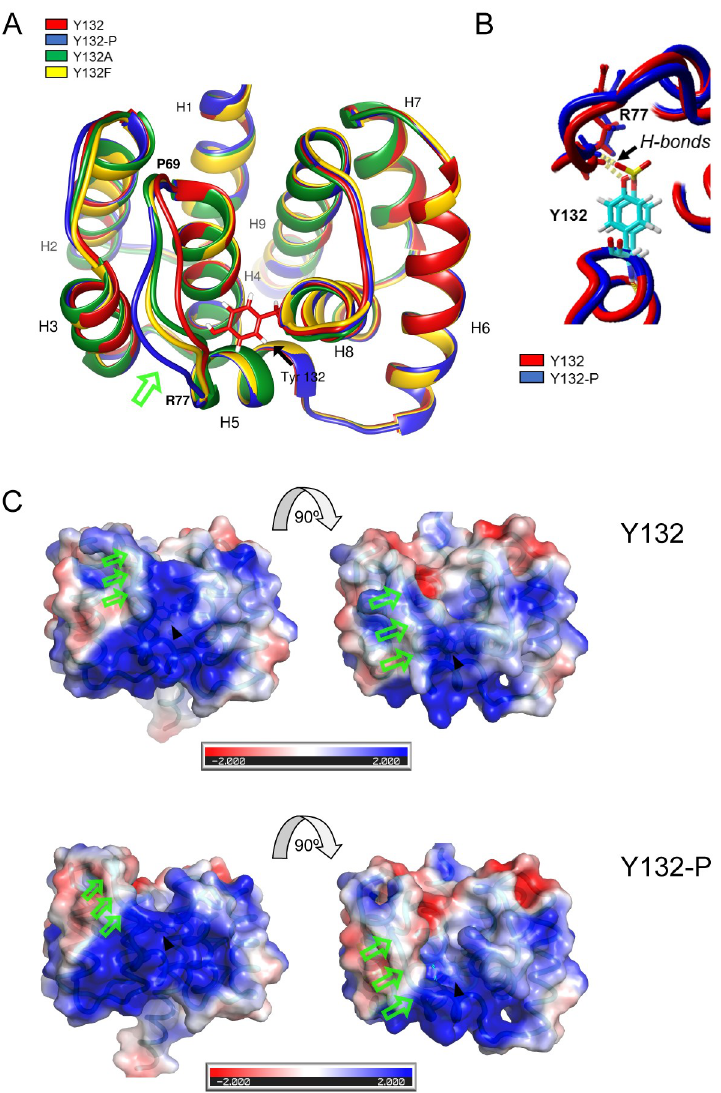
Fig 2. Phosphorylation of M1 Y132 induces a potential structural repositioning of the linker domain between helices 4 and 5. A) WSN M1 WT, pY132, Y132A and Y132F were modeled based on the solved and refined crystal structure (pdb: 5v8a) and all atoms mobile molecular dynamics simulations were performed. Average structures of WT and mutant models are colored as indicated and shown superimposed. B) Proposed hydrogen bond replacement resulting in a repositioning of the linker domain in M1 pY132. C) Surface representation of non-phosphorylated M1 in comparison to pY132, colored by the electrostatic potential calculated by Poisson-Bolzman with positive in blue and negative in red, viewed from different directions. Arrows highlight repositioned linker (green) and Y132 (black).